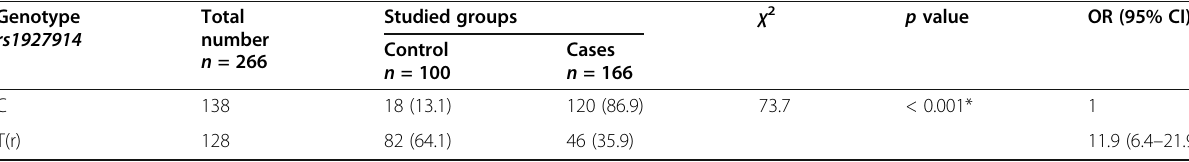
Table 3 Association between rs1927914 alleles and epileptic cases Genotype